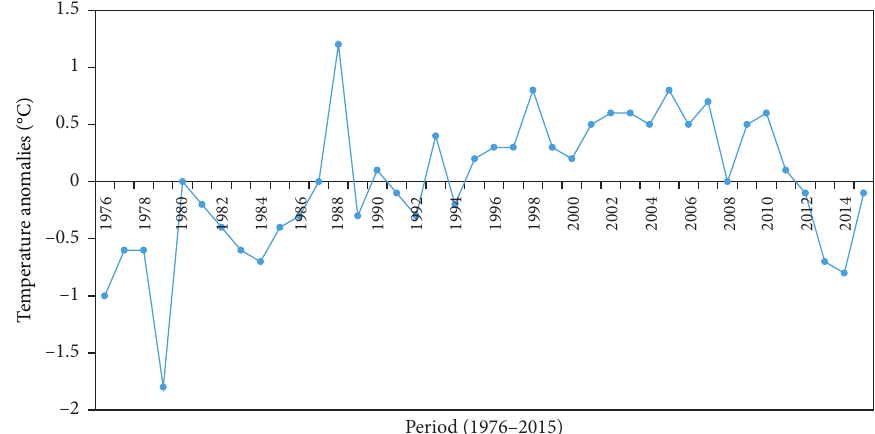
Figure 9: Mean annual temperature